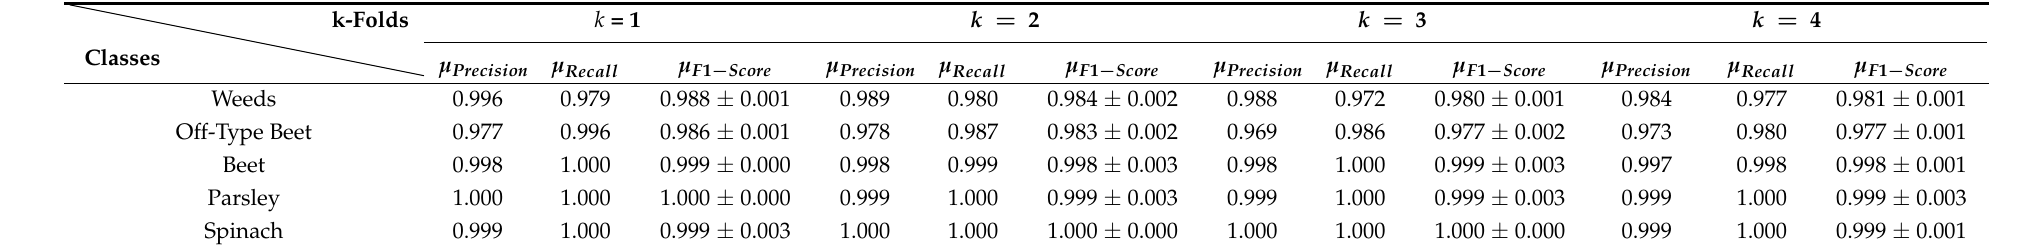
Table 3. Comparison of classification reports generated from 5-Fold cross-validation leaving k folds out (where k-folds stands for the number of validation folds) with 1 ≤ k ≤ 4. k = 1 represents the most number of training images (12,844) and k = 4 represents the lowest number of training images (3211). The average precision, recall and F1-Score, obtained using Equation (10) are reported for each class obtained with the ViT B-16 model.